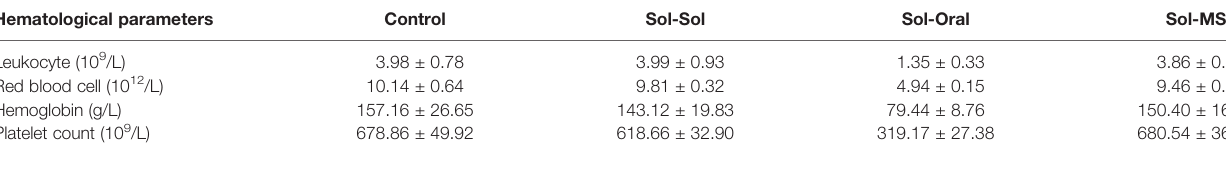
TABLE 5 | The effect of sorafenib formulations on immunode fi ciency rat ’ s body weight and main organs mass. Hematological parameters